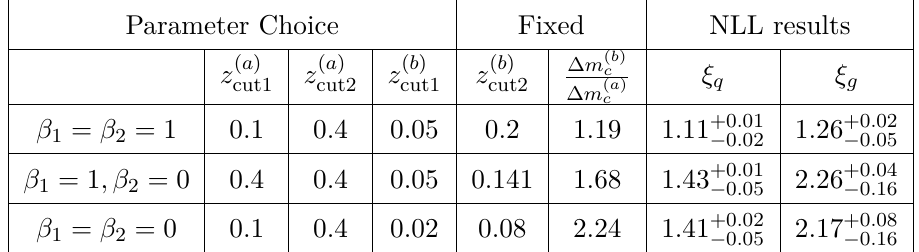
Table 1. Cases considered for the β i , z ( a ) η J = 0 and R = 0 . 2 the required values for z ( b ) and our NLL determination of the corresponding ξ q and ξ g are also